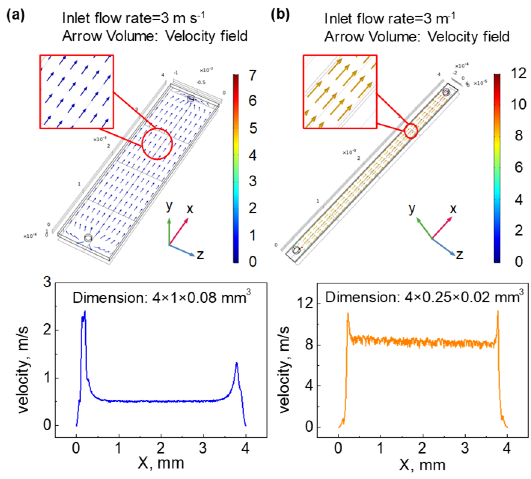
Figure 3. COMSOL simulation of analyte (ethanol) flow rate magnitude for different sizes of gas chambers. ( a ) 4 × 1 × 0.08 mm 3 . ( b ) 4 × 0.25 × 0.02 mm 3 . The data graph below shows the velocity